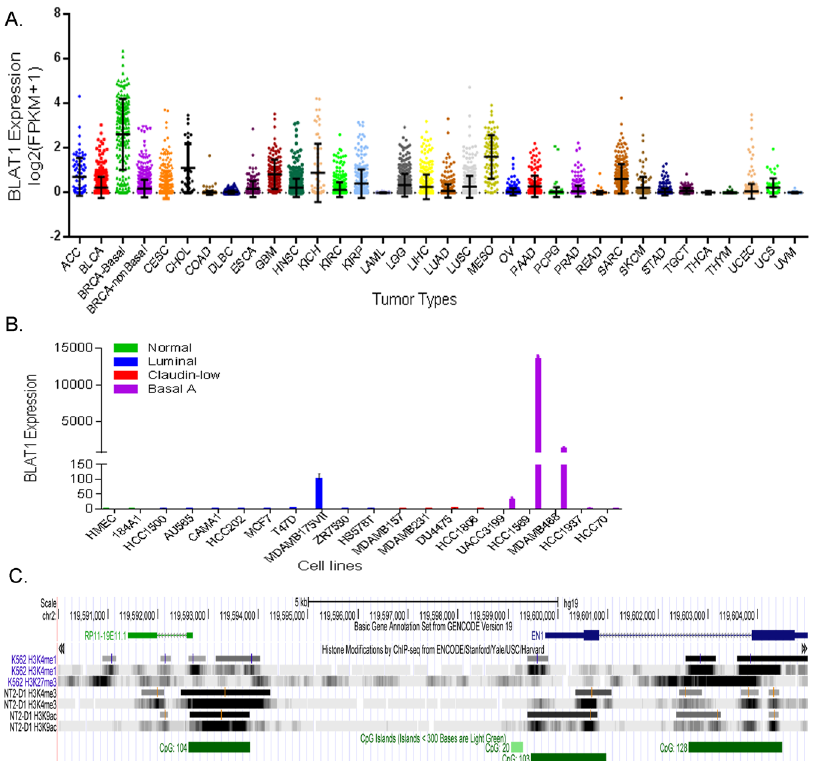
Figure 2. BLAT1 Expression in Pan-Cancers and Breast Cancer Cell Lines, and In Silico Analysis. ( A ) BLAT1 expression was analyzed using Pan-Cancer RNA-seq datasets. The values are presented as log 2 (FPKM + 1). ACC, Adrenocortical Carcinoma; BLCA, Bladder Urothelial Carcinoma; BRCA, Breast Invasive Carcinoma; CESC, Cervical Squamous Cell Carcinoma and Endocervical Adenocarcinoma; CHOL, Cholangiocarcinoma; COAD, Colon Adenocarcinoma; DLBC, Lymphoid Neoplasm Diffuse Large B-cell Lymphoma; ESCA, Esophageal Carcinoma; GBM, Glioblastoma Multiforme; HNSC, Head and Neck Squamous Cell Carcinoma; KICH, Kidney Chromophobe; KIRC, Kidney Renal Clear Cell Carcinoma; KIRP, Kidney Renal Papillary Cell Carcinoma; LAML, Acute Myeloid Leukemia; LGG, Brain Lower Grade Glioma; LIHC, Liver Hepatocellular Carcinoma; LUAD, Lung Adenocarcinoma; LUSC, Lung Squamous Cell Carcinoma; MESO, Mesothelioma; OV, Ovarian Serous Cystadenocarcinoma; PAAD, Pancreatic Adenocarcinoma, PCPG, Pheochromocytoma and Paraganglioma; PRAD, Prostate Adenocarcinoma; READ, Rectum Adenocarcinoma; SARC, Sarcoma; SKCM, Skin Cutaneous Melanoma; STAD, Stomach Adenocarcinoma; TGCT, Testicular Germ Cell Tumors; THCA, Thyroid Carcinoma; THYM, Thymoma; UCEC, Uterine Corpus Endometrial Carcinoma; UCS, Uterine Carcinosarcoma; UVM, Uveal Melanoma. ( B ) Expression of BLAT1 was analyzed in twenty beast cell lines by qRT-PCR relative to the expression in non-malignant breast cells (184A1 and HMEC). HCC-1569 and MDA-MB-468 cells showed the highest expression among twenty cell lines. ( C ) UCSC genome browser view of 2q14.2 (hg19) shows the close location (within 7 Kb) of BLAT1 ( RP-11-19E11 . 1 ) and EN1 . BLAT1 has a rich epigenetic landscape (ChIP-seq data from ENCODE) and CpG islands in the regulatory